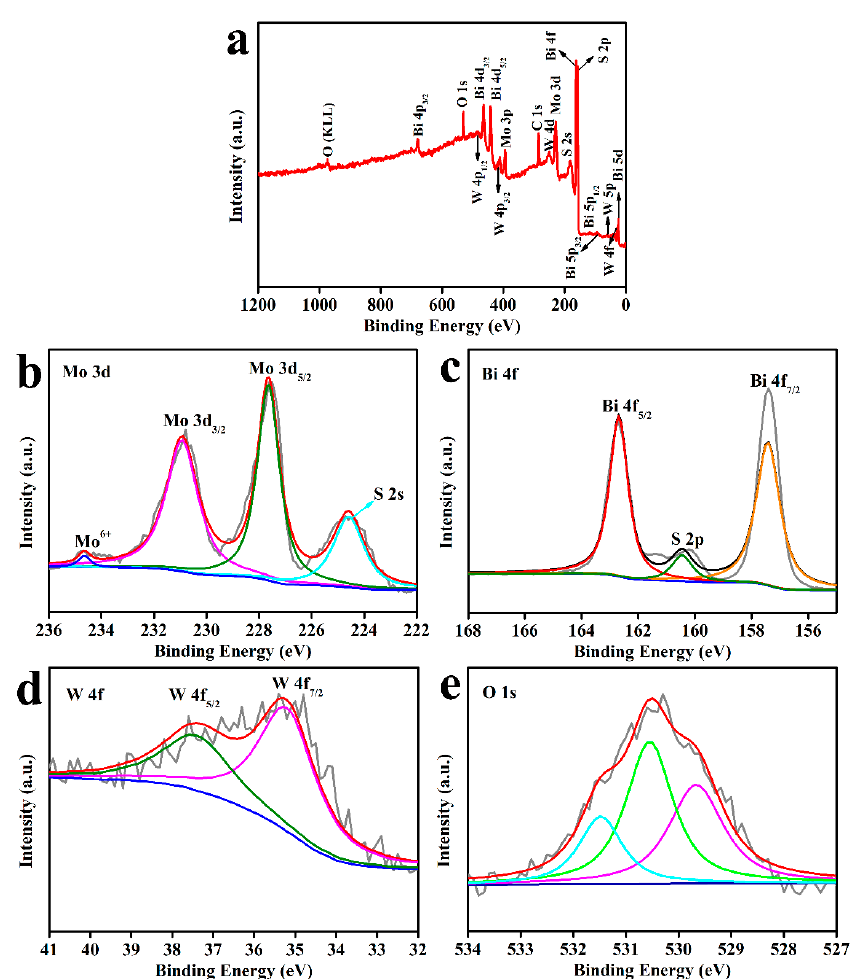
Figure 3. X-ray photoelectron spectroscopy (XPS) analysis of BBM-3 showing ( a ) survey, ( b ) Mo 3d, ( c ) Bi 4f, ( d ) W 4f, and ( e ) O 1s spectra.